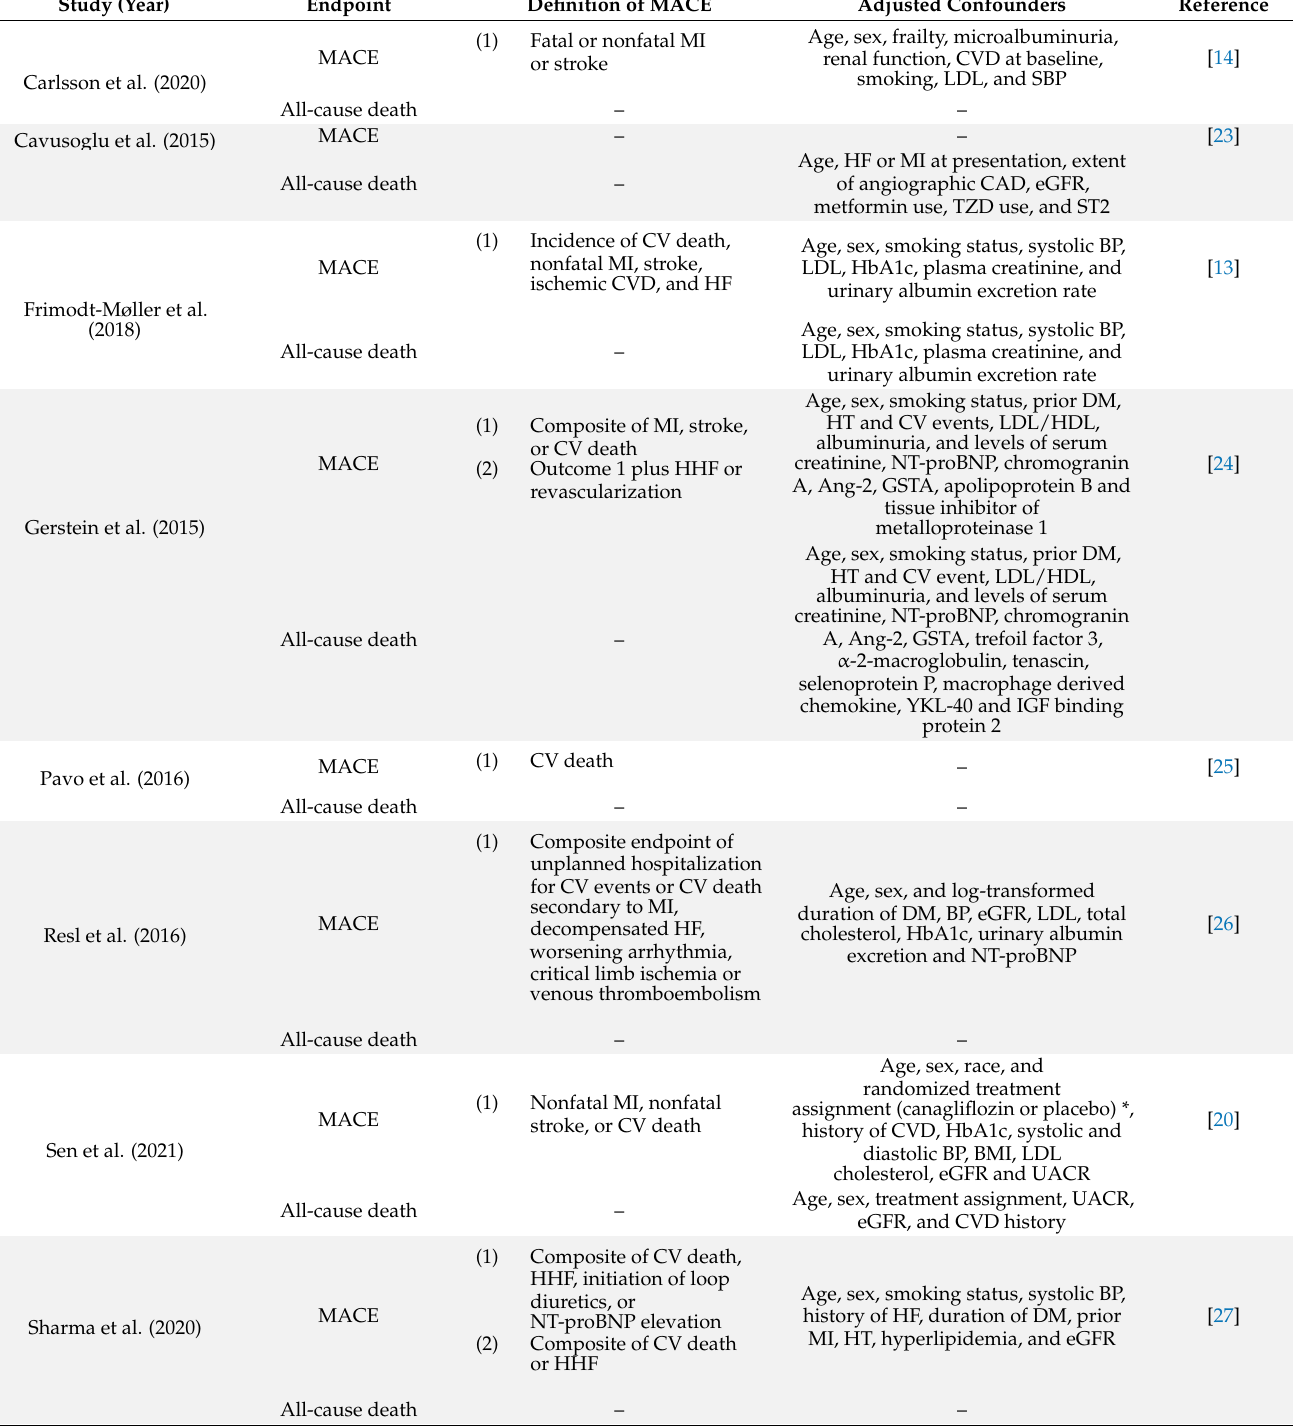
Table 2. Definition of study endpoints, MACE, and adjusted confounders in the included